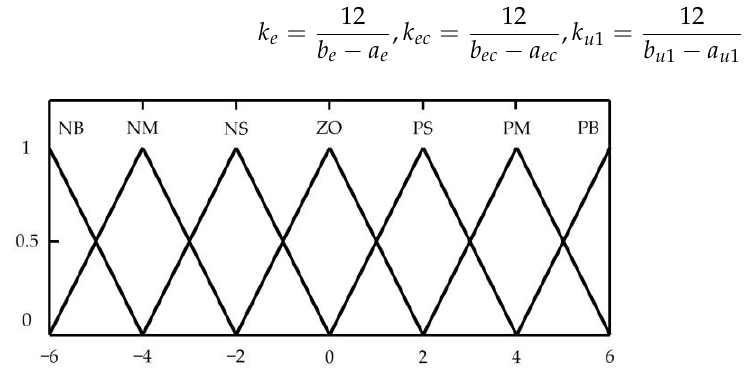
Figure 9. Triangle membership function. Figure 8. Fuzzy PID controller framework diagram.